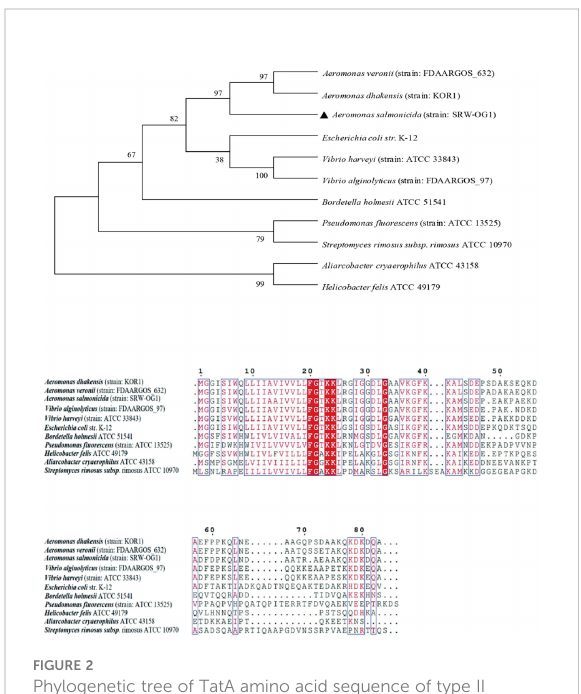
FIGURE 3 Phylogenetic tree of TatB amino acid sequence of type II secretion